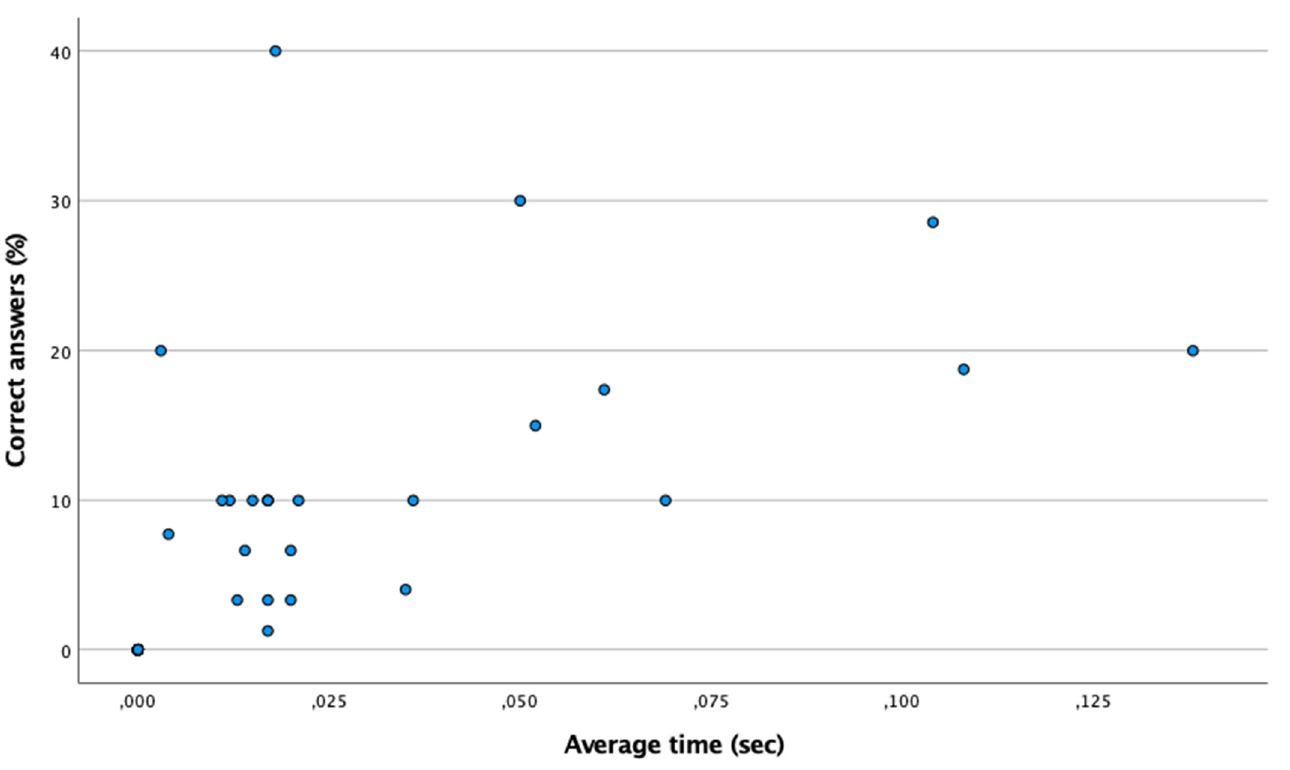
Figure 1. Positive linear relationship between the percentage of correct answers and the mean time in the anticipation time test. The point (0,0) means that there is no correct answer.